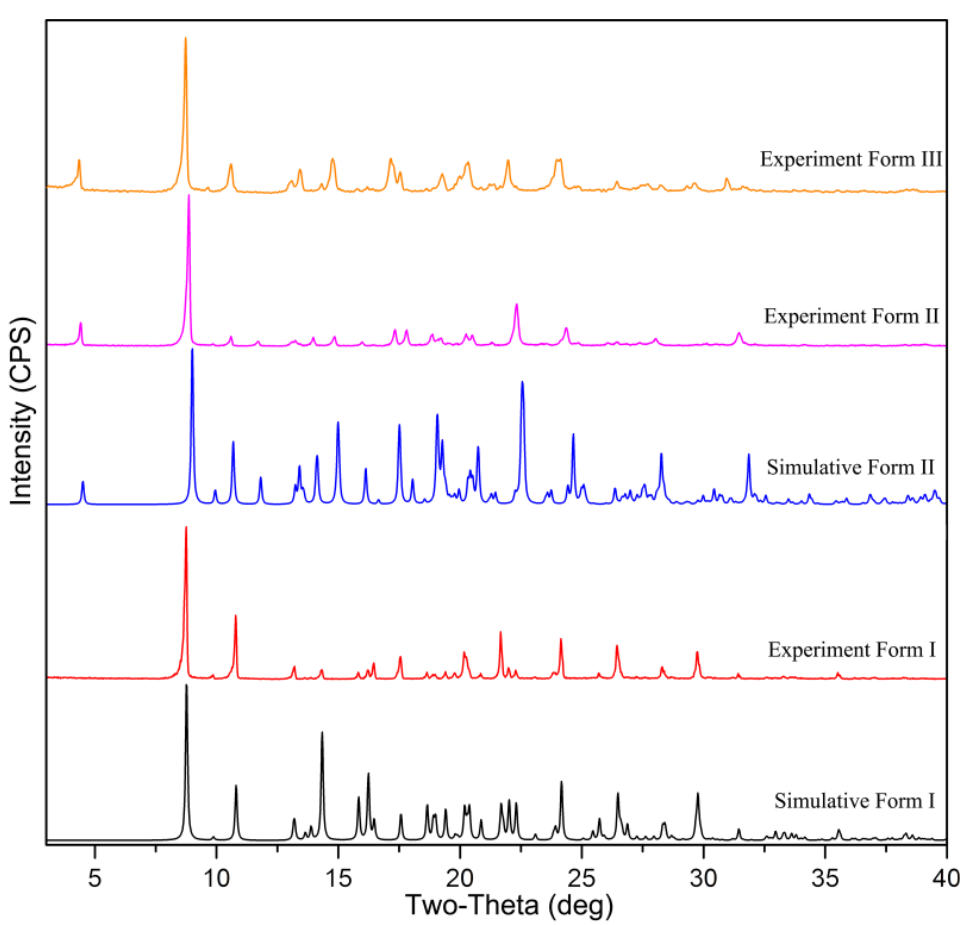
Figure 4. PXRD patterns of all here described solid forms of BXM.